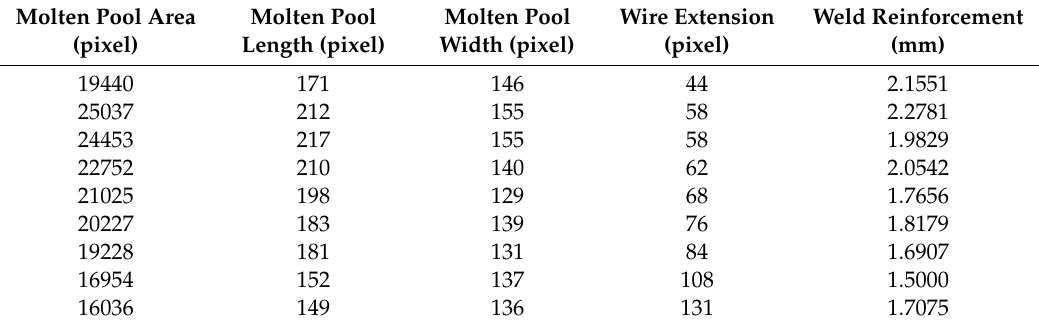
Table 4. Partial data of molten pool features and corresponding weld